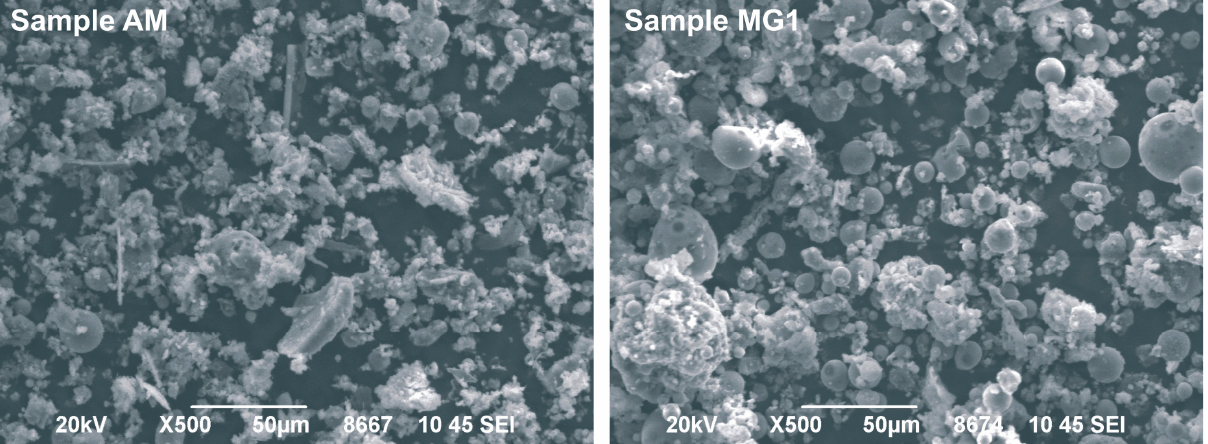
Figure 2. Representative SEM images of the studied fly-ash samples.